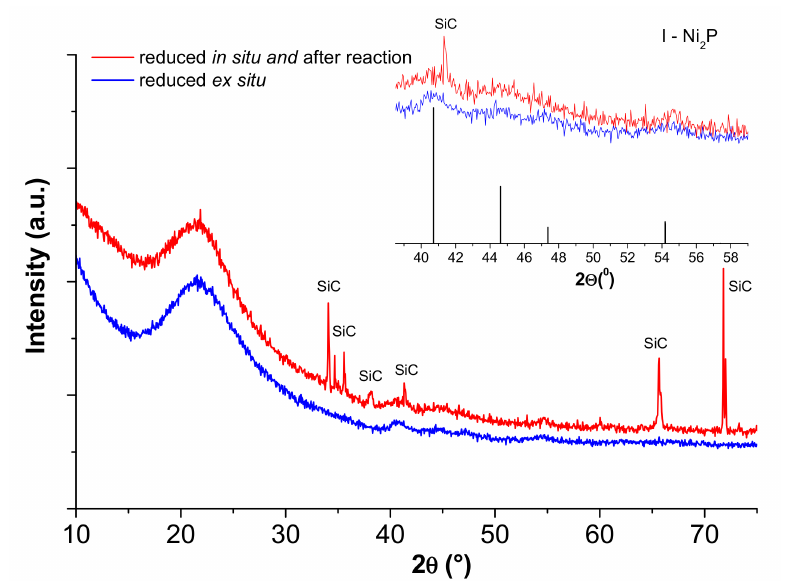
Figure 1. XRD patterns of Ni 2 P/SiO 2 catalysts obtained by ex situ reduction and by in situ reduction and exposed to the catalytic